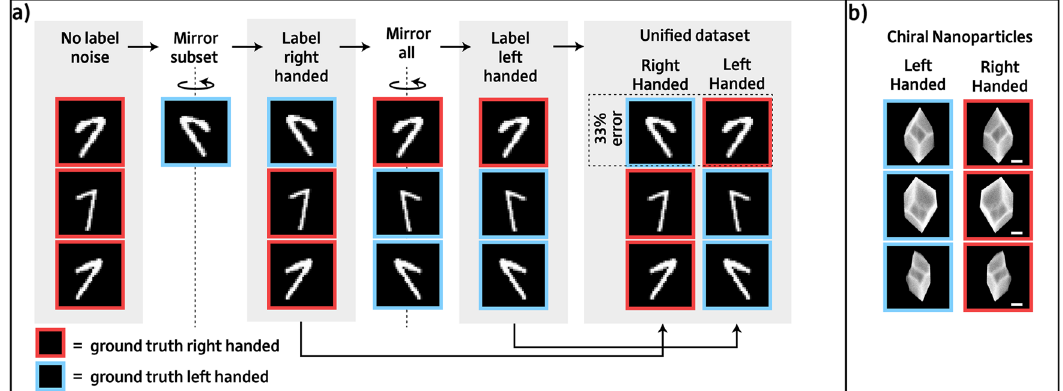
Fig. 1 The mirror labeling scheme used for data labeling with sample images. a Schematic demonstrating the mirror labeling procedure by which training datasets are automatically labeled and the error rate in the dataset is controlled on the MNIST seven dataset. b Examples of images for both classes from the chiral nanoparticle datasets. Scale bars, 100 nm.